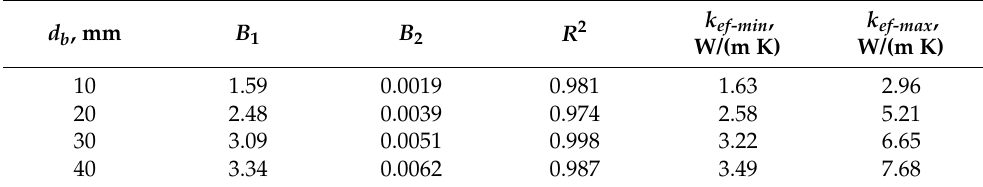
Figure 5. Measured effective thermal conductivity vs. temperature for flat packed beds of steel bars. Table 1. The values for B 1 , B 2 , R 2 , k ef-min , and k ef-max coefficients obtained for the individual diameters of the bars.